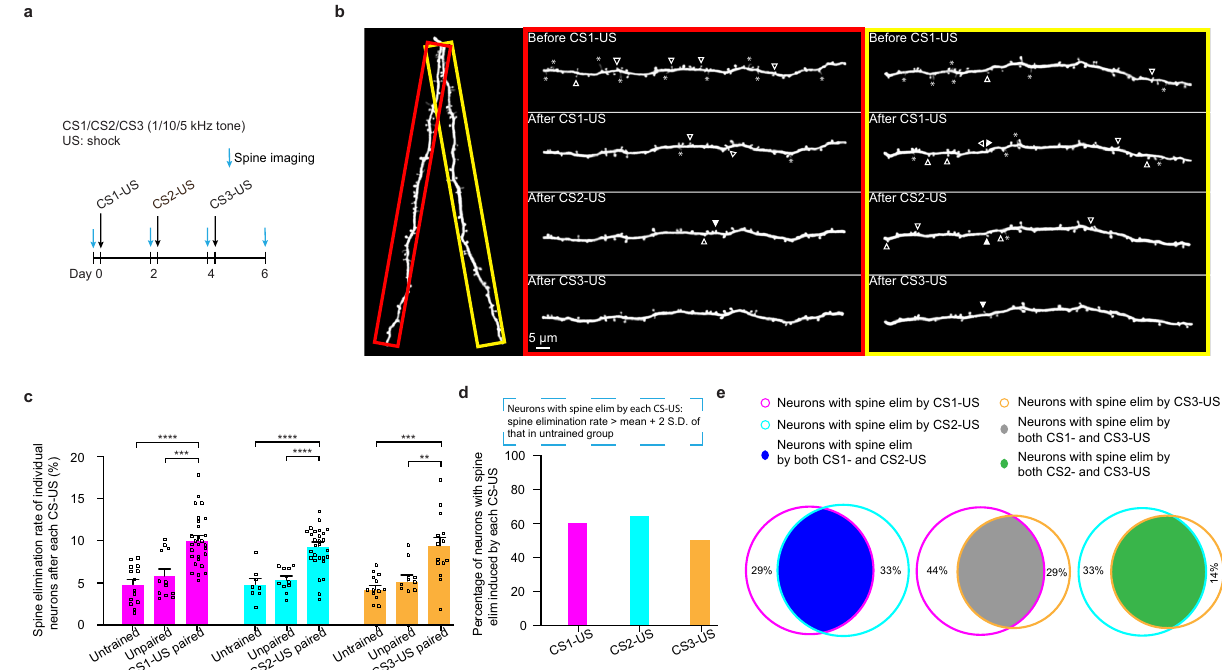
Fig.3|DistributionofspineeliminationinducedbydifferentCS-USpairingson individual neurons. a Experimental design to examine spine elimination induced bydifferentCS-USsinthemotorcortexofYFP-Hlinemice(CS1:1kHz;CS2:10kHz; CS3: 5kHz). b Representative images of spine elimination induced by three dif- ferent CS-USpairingsonapicaldendritic branchesfrom same neuroninYFP-Hline mice. The hollow triangles indicate the spines eliminated in the succeeding image. The solid triangles indicate the newly-formed spines when compared to the pre- ceding image. The asterisks indicate fi lopodia. Experiments were repeated inde- pendently on 36 branches in 14 mice with similar results. c Comparison of spine elimination rates of individual neurons (circles) between mice subjected to differ- ent CS-US pairings and untrained or unpaired control mice (CS1-US pairing vs. untrained or unpaired, P <0.0001 or P =0.0003, respectively; n=28, 14 and 12